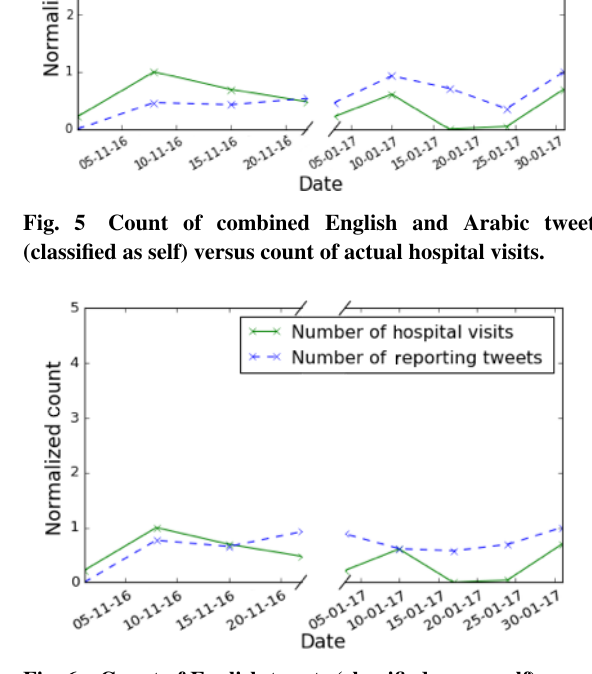
Fig. 6 Count of English tweets (classified as nonself) versus count of actual hospital